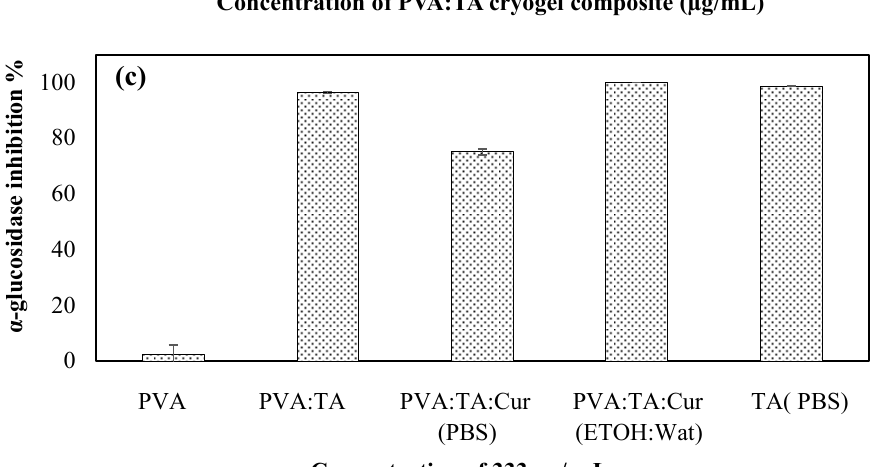
Figure 7. The α -glucosidase inhibitory activity of (a) TA, (b) PVA:TA cryogel composites at pH 7.4 PBS (different concentrations; 333, 167, 83, 42, and 21 µg/mL). (c) The α -glucosidase inhibitory activity of PVA:TA cryogel composites at pH 7.4 (at 333 µg/mL concentration).